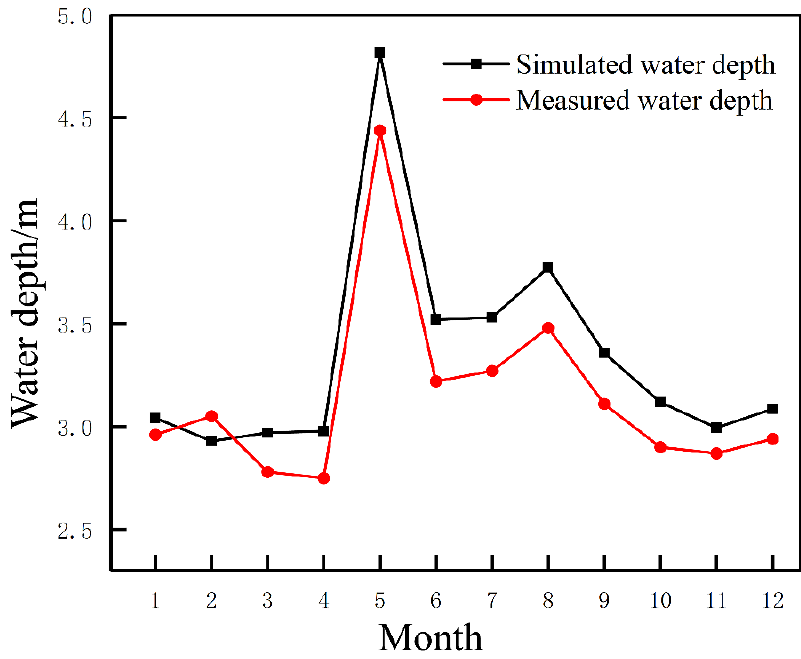
Figure 3. Calculated and observed water depth of Tangmazhai station.